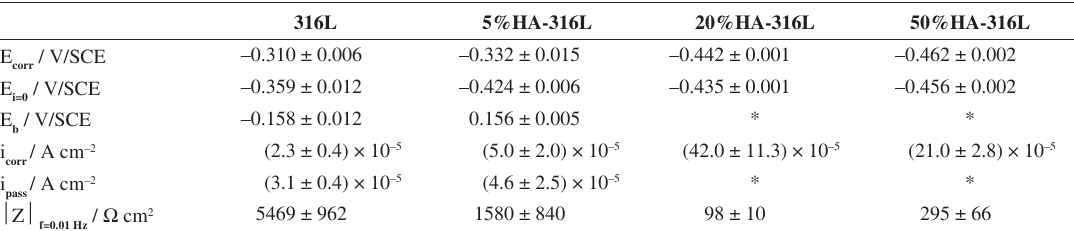
Figure 7. Bode diagrams of sintered 316L stainless steel and HA- Figure 6. Polarization curves of sintered 316L stainless steel and 316L composites in 0.1M HCl solution at room temperature and at corrosion HA‑316L composites in 0.1M HCl solution at room temperature. Table 3. Corrosion potential (E ), null‑current potential (E ), breakdown potential (E ), corrosion current density (i ), passive current corr i=0 b corr density (i measured at the middle of the passive region) and impedance modulus (|Z| measured at 0.01 Hz) of sintered 316L stainless pass steel and HA‑316L composites in 0.1M HCl solution at room temperature.